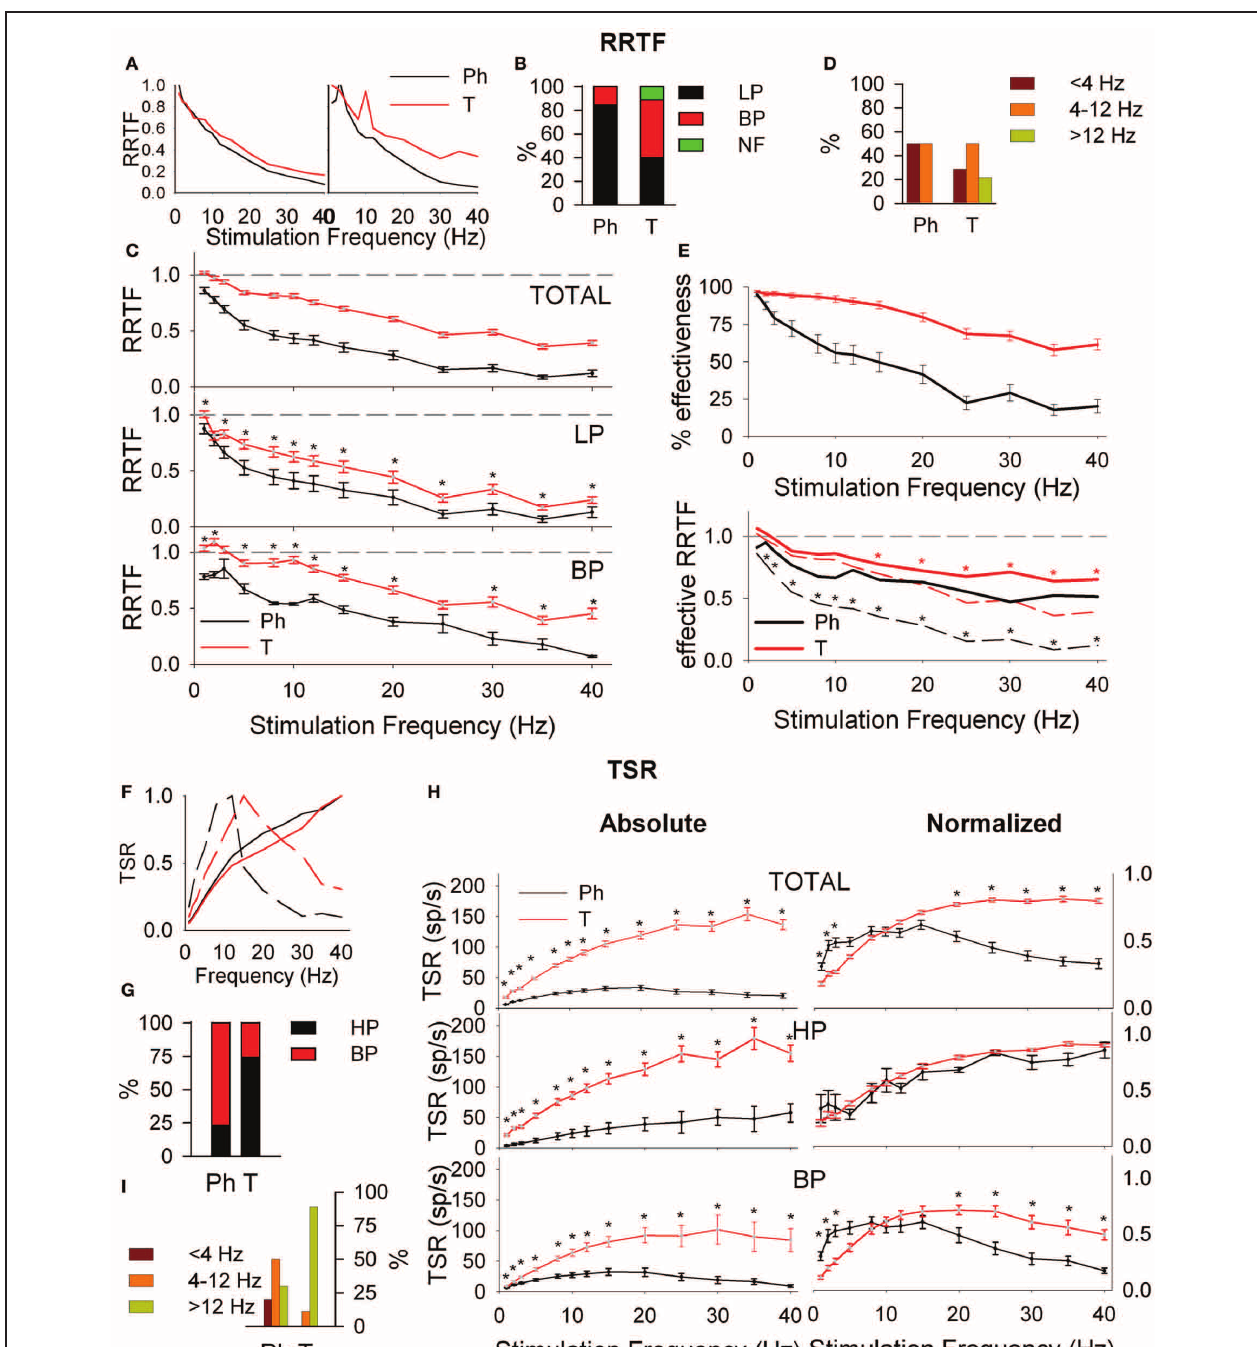
neurons (top) and RRTF function calculated using only effective stimuli (bottom). (F) Typical total spike response functions (TSR) of high-pass (HP, continuous lines) and BP (dashed lines) cells. (G) Percentages of HP and BP populations among Ph and T neurons. (H) Mean absolute (left) and normalized (right) TSR values for Ph and T responses pooled all together (top) and considering HP and BP separately (middle and bottom). (I) Distribution of BP peak frequencies for Ph and T neurons in the three frequency ranges: below ( < 4Hz), into (4–12Hz), and above ( > 12Hz) whisking. ( ∗ ) indicate adjusted p -values < 0.05 (FDR procedure, 13 comparisons). In (E) red stars correspond to comparisons of tonic neurons and black stars to